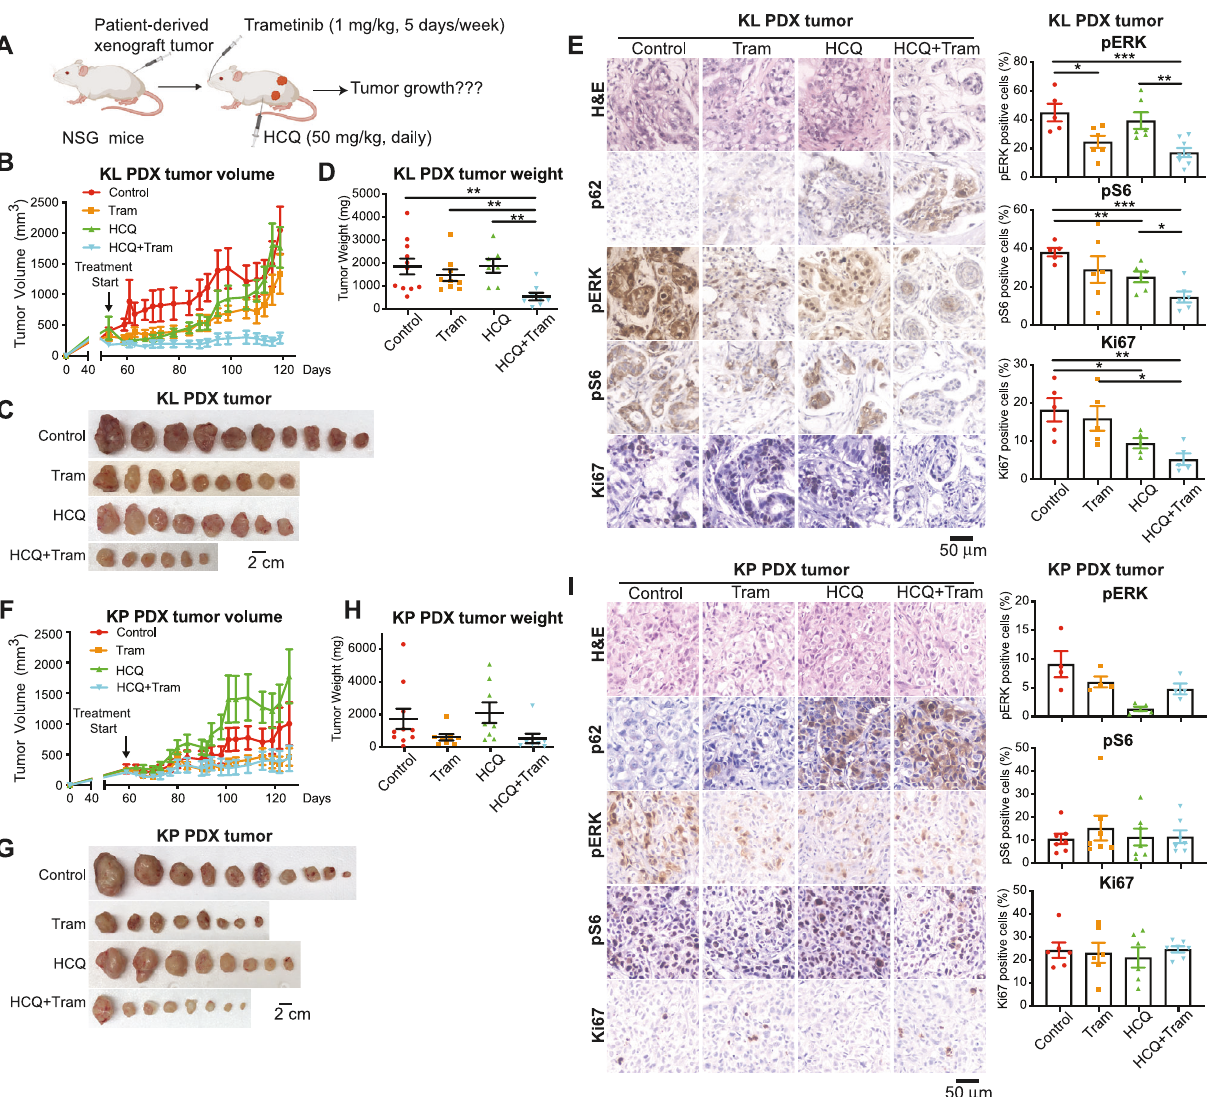
Fig. 4 HCQ increased the sensitivity of KL PDX tumors, not KP PDX tumors, to MEK inhibitor Trametinib. A Scheme of Patient-Derived Xenograft (PDX) tumor model treated with vehicle control, HCQ (50 mg/kg, daily, I.P.), Trametinib (Trametinib, 1 mg/kg, 5 days/week, oral gavage), or the combination. B Graph of KL PDX tumor growth in NSG mice treated with vehicle control, HCQ, Trametinib or the combination for 10 weeks. C Gross pathology of KL PDX tumors. D KL PDX tumor weight at the end of experiment. E H&E and IHC for p62, pERK, pS6, and Ki67 (left panel) and quanti fi cation of pERK, pS6, and Ki67 (right panel) of KL PDX tumors. F Graph of KP PDX tumor growth in NSG mice treated with vehicle control, HCQ, Trametinib, or the combination for 9.5 weeks. G Gross pathology of KP PDX tumors. H. KP PDX tumor weight at the end of experiment. I H&E and IHC for p62, pERK, pS6, and Ki67 (left panel) and quanti fi cation of pERK, pS6, and Ki67 (right panel) of KP PDX tumors. Data are mean ± s.e.m. * P < 0.05; ** P < 0.01; *** P <